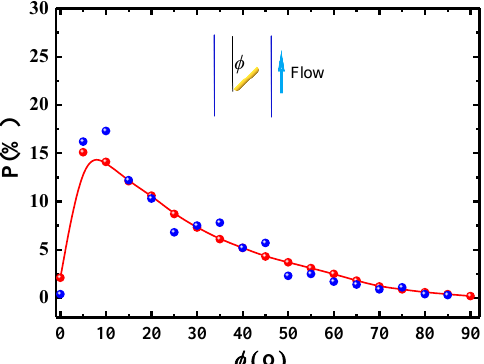
Figure 2. Probability distribution of mean cylindrical particle orientation ( λ = 8, Re = 10,000). ●: numerical results and ●: experimental results [24].